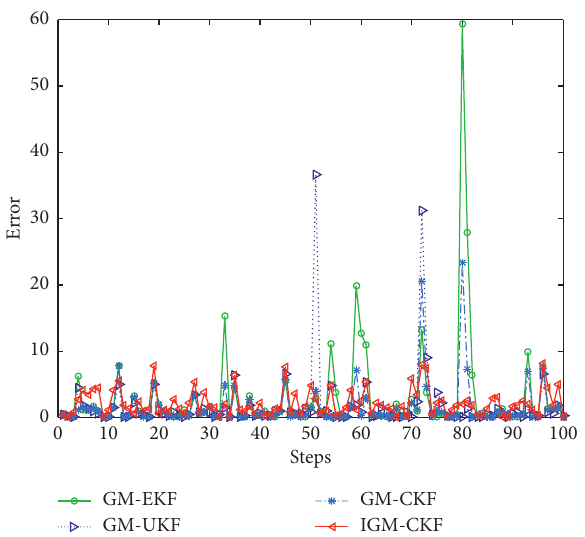
Figure 2: The error of various filtering algorithms.